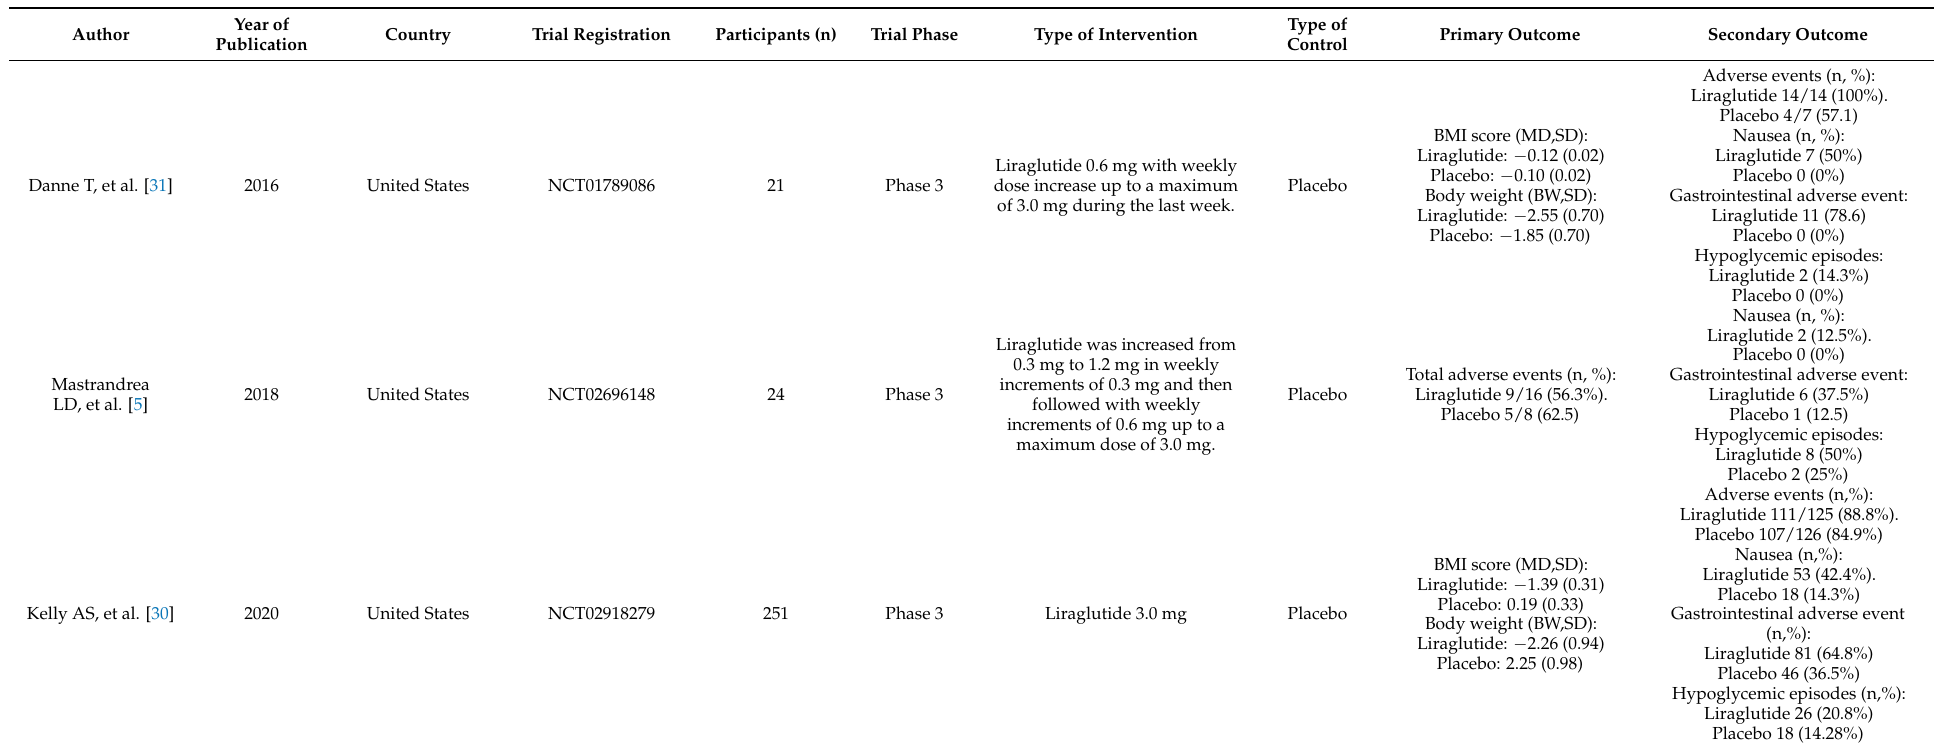
Table 1. The main characteristics of the included